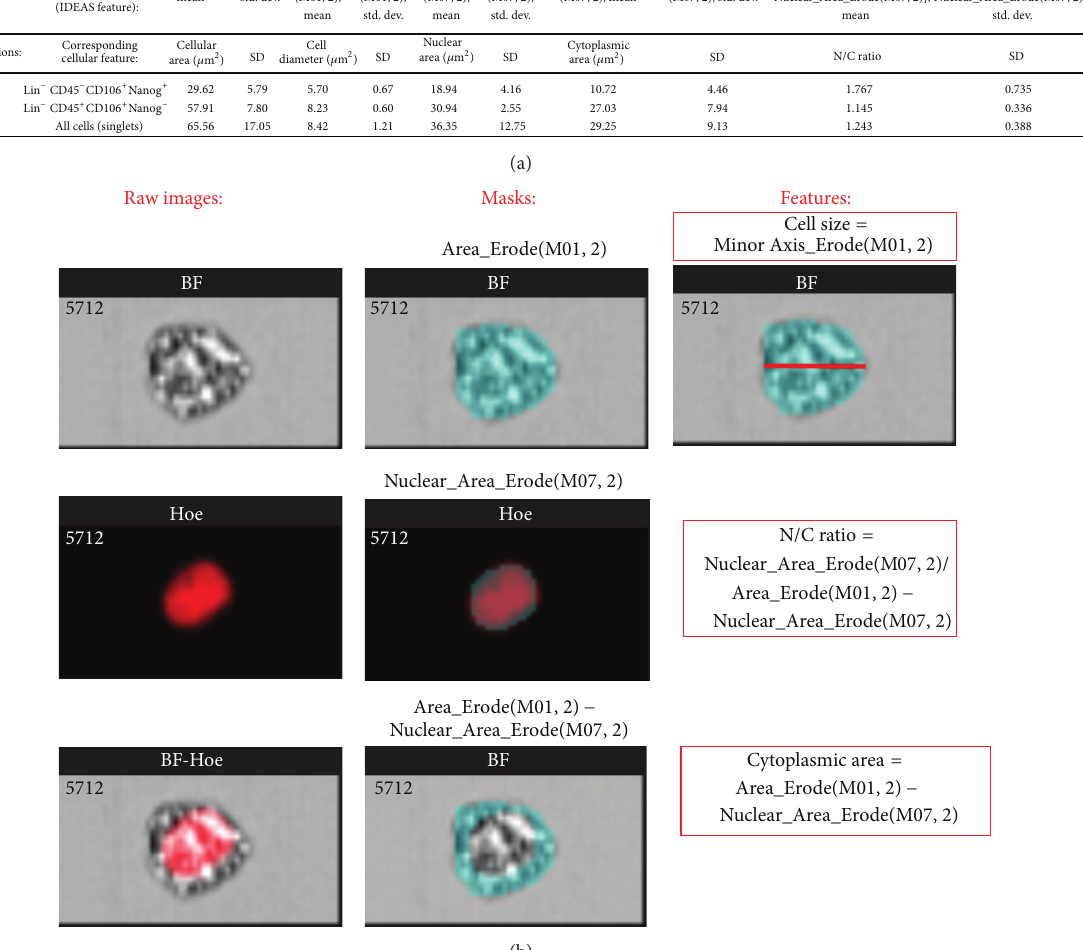
Figure 4: Quantitative analysis of morphological features of selected rat BM populations by ImageStream X system. (a) Quantitative analysis of cell size, nuclear to cytoplasmic (N/C) ratio, and cytoplasmic area of rVSELs when compared to other cell types. Analysis was performed based on the collected images of following rat BM populations: (i) rVSELs: CD45 − /Lin − /CD106 + cells expressing Oct-4A or Nanog (upper and lower table, resp.); (ii) rHSCs: CD45 + /Lin − /CD106 + cells with no expression of Oct-4A and Nanog, and (iii) TNCs (gated as singlets during the analysis). Analyses were performed with IDEAS software (Amnis Corp.). Data are shown as average values of each indicated feature within the cell population (mean ± SD). (b) Analytical approach for masking and feature calculation by IDEAS. Images show brightfield (BF), nuclear (Hoe), and combined (BF-Hoe) images of one example rat BM cell as well as exact masks (cyan) and features (formulas based on the defined masks) that were optimized and used for the analysis shown in (a). Cell size was expressed as minor cell axis computed within the mask covering BF image, while cytoplasmic area and N/C ratio were calculated based on the areas of BF and nuclear images (as indicated in red boxes). All masks and features including their nomenclature represent standard parameters provided by IDEAS software (Amnis